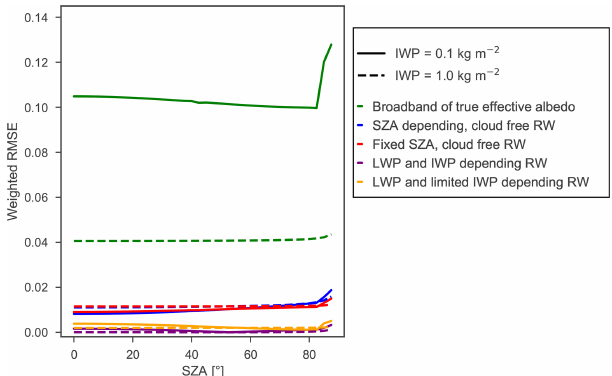
Figure 7. Weighted RMSE as a function of SZA with respect to RWs if LWP, IWP and SZA are all taken into account. The weighted RMSE is computed for different methods, keep- ing LWP=0.1kgm − 2 constant. The uninterrupted lines represent IWP=0.1kgm − 2 and the dashed lines IWP=1.0kgm − 2